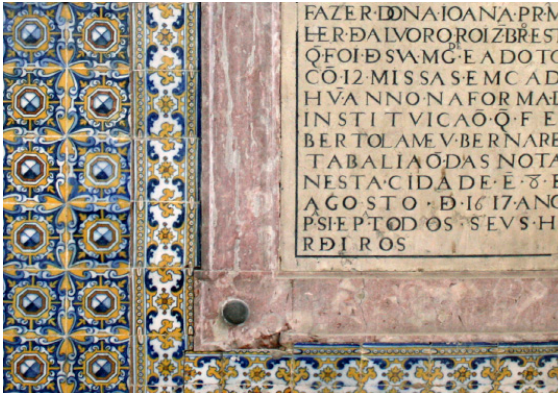
frames used as a bar.